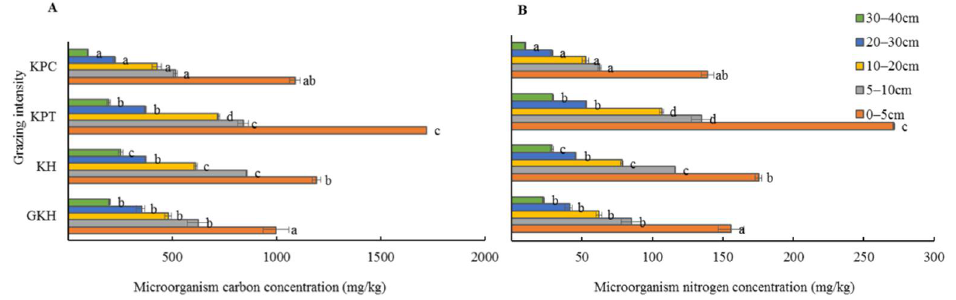
Figure 11. Concentrations of microbial carbon (C) ( A ) and nitrogen (N) ( B ) at different grazing intensities: GKH (3.75 ± 0.75 sheep/ha), KH (7.25 ± 0.25 270 sheep/ha), KPT (8.50 ± 0.35 sheep/ha), and KPC (11.75 ± 0.95 sheep/ha). Notations: different letters indicate significant differences between pastures ( α = 0.05).